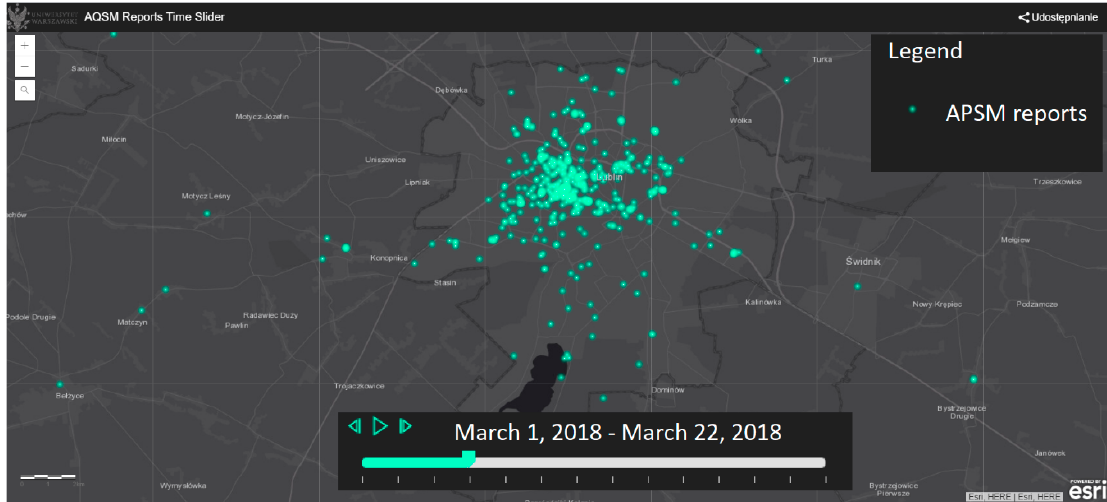
Figure A6. Time slider app following the data collection process over time.